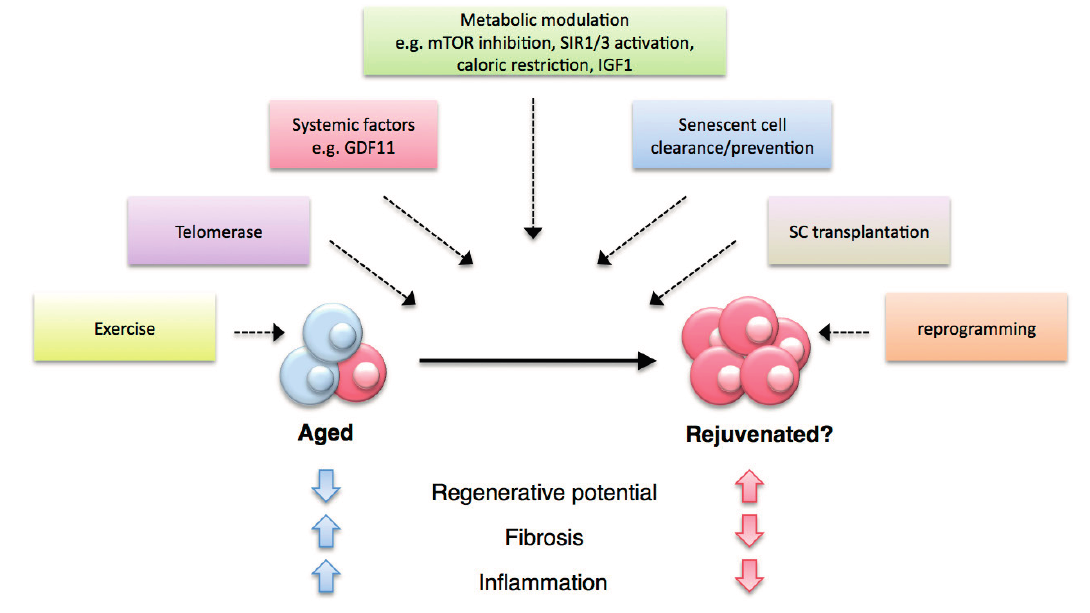
Figure 5. Therapeutic strategies for improving regenerative